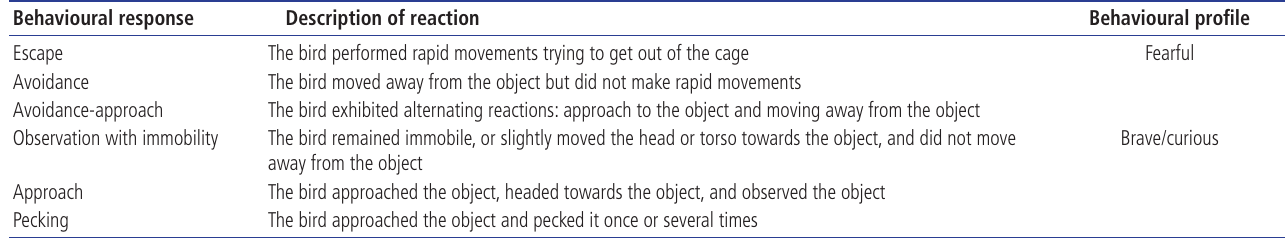
Table 2. Description of behavioural responses characteristic of the behavioural profiles Behavioural response Description of reaction